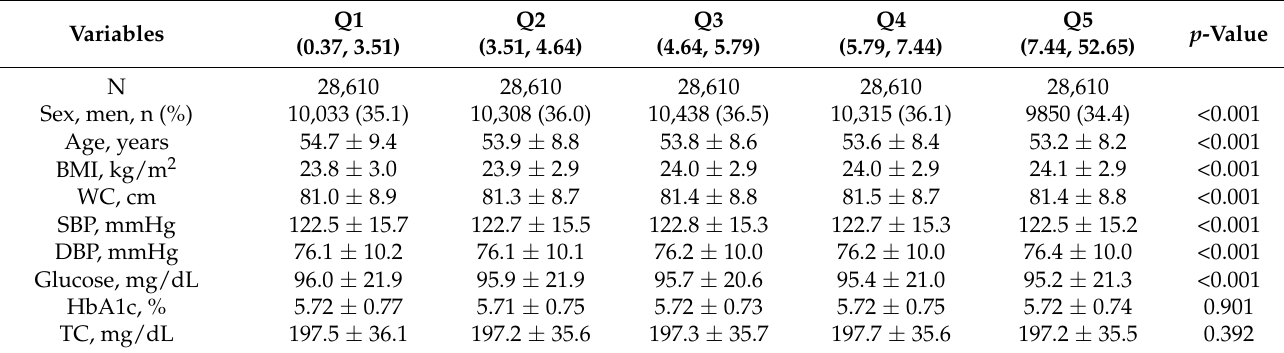
Table 1. Baseline characteristics of the cohort according to fiber intake